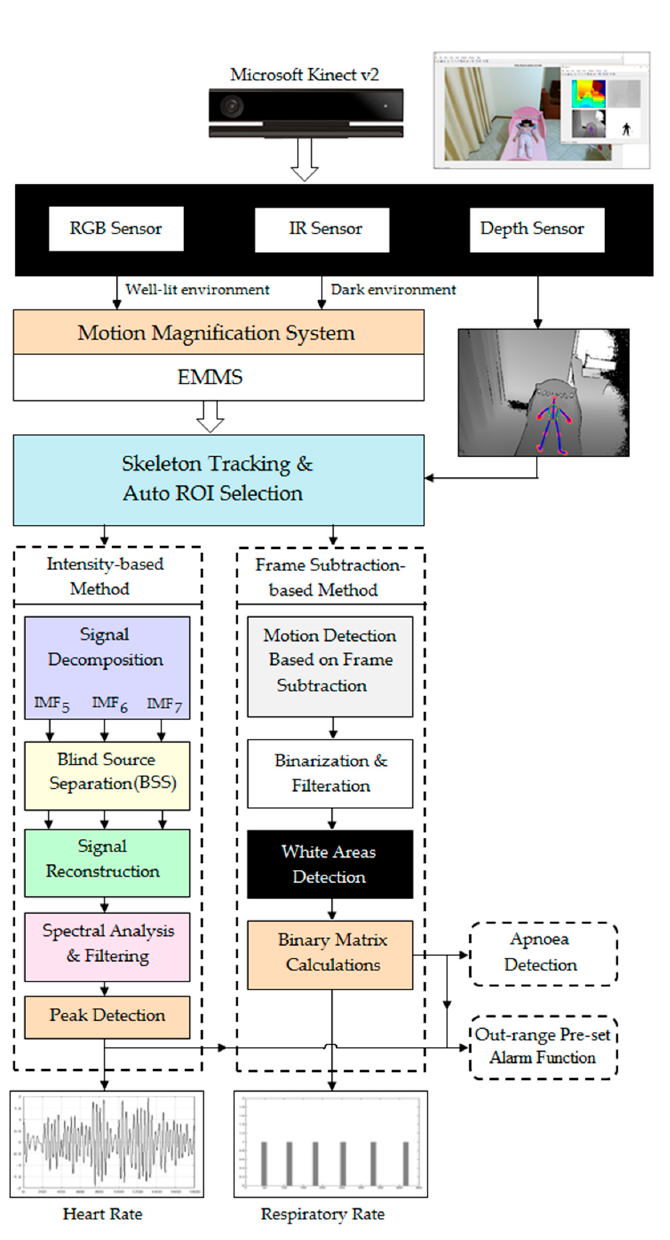
Figure 2. Block diagram of the proposed system based on a Microsoft Kinect v2 sensor.